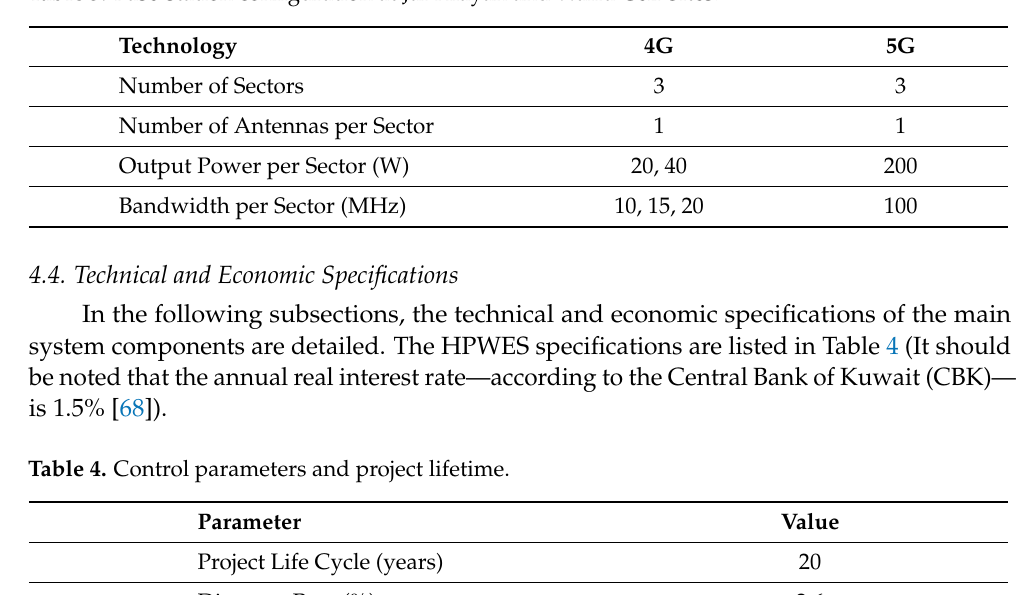
Table 3. Base-station configuration at Jal-Alayah and Wafra Cell-Sites.